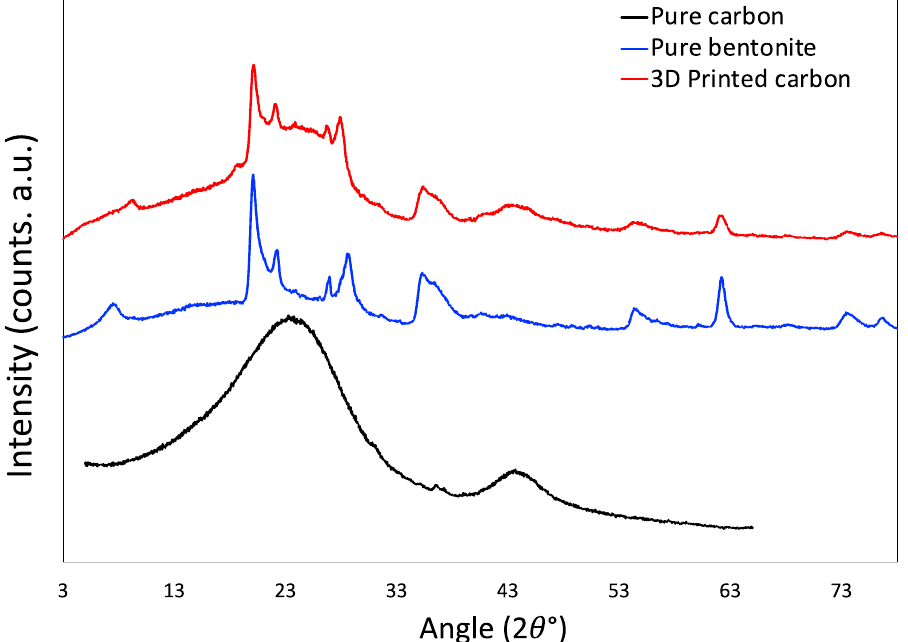
Figure 7. X-ray diffraction patterns of 3D printed carbon monolith, pristine bentonite, and pristine porous carbon without bentonite.